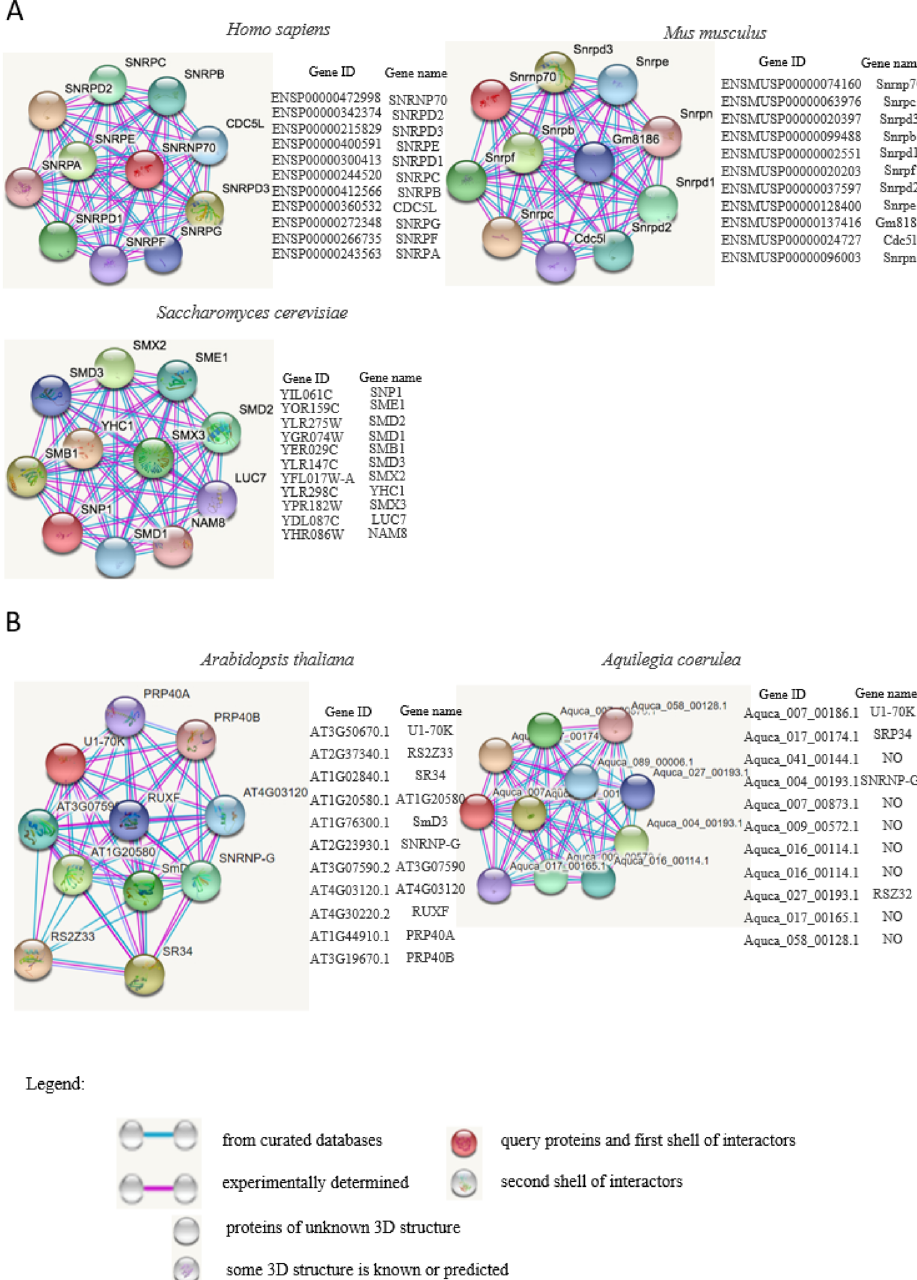
Figure 3. Protein–protein interaction networks of representative animal species ( A ) and plant species ( B ). Known interactions, either determined by experiments (pink line) or from curated databases (blue line) are presented in protein–protein interaction networks. U1-70Ks of Homo sapiens , Mus musculus , Saccharomyces cerevisiae , Arabidopsis thaliana and Aquilegia coerulea are used as query protein for analysis by STRING database. Highly scored interactors are presented in the form of network diagram. Empty notes are proteins of unknown 3D structure, while filled notes are proteins with known or predicted 3D structure in current